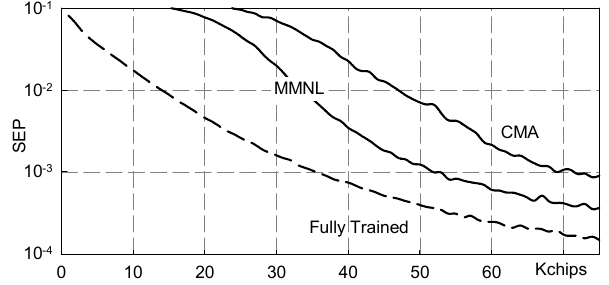
Figure 11. SEP vs. transmitted chips: channel (21), NSR = 20